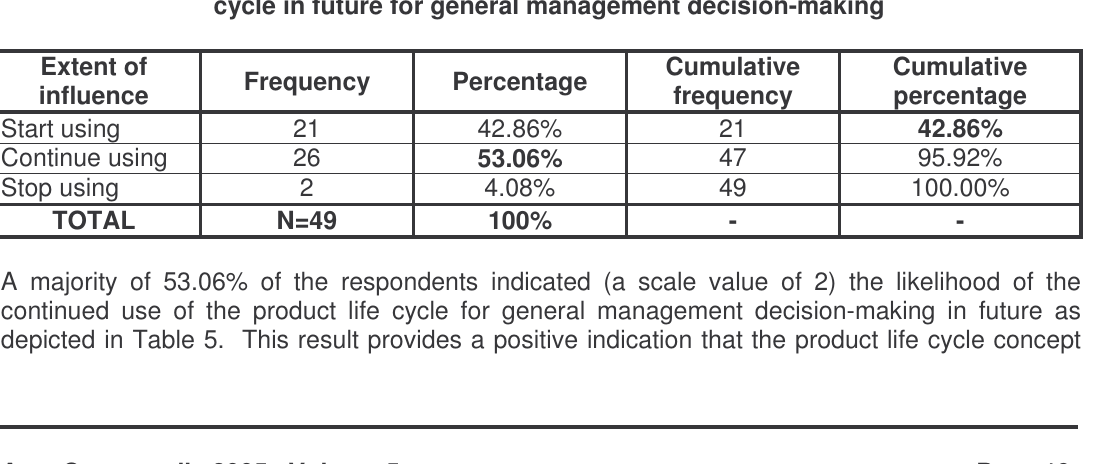
Likelihood of starting, continuing or stopping the use of the product life cycle in future for general management